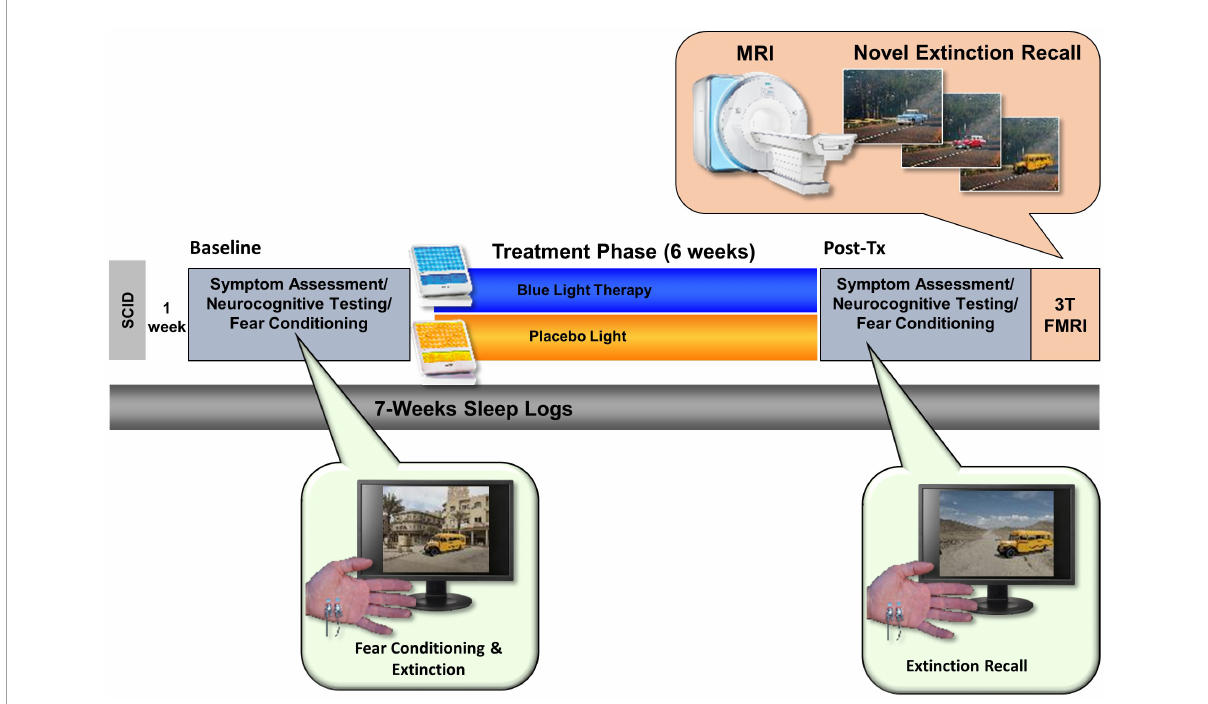
FIGURE2 The total study lasted 7 weeks and comprised an initial visit for a structured clinical interview. After 1 week, participants returned for a Baseline assessment day that included neurocognitive testing (including a fear conditioning and extinction protocol). Participants were then randomly assigned to either the Blue Light Treatment (BLT) or placebo Amber Light Treatment (ALT). During treatment, participants used a lightbox (blue or amber) each morning for 30 min over the 6-week period. Participants returned to complete the same assessment battery at the end of the study as well as a 3T fMRI scan while engaging in a novel context extinction recall